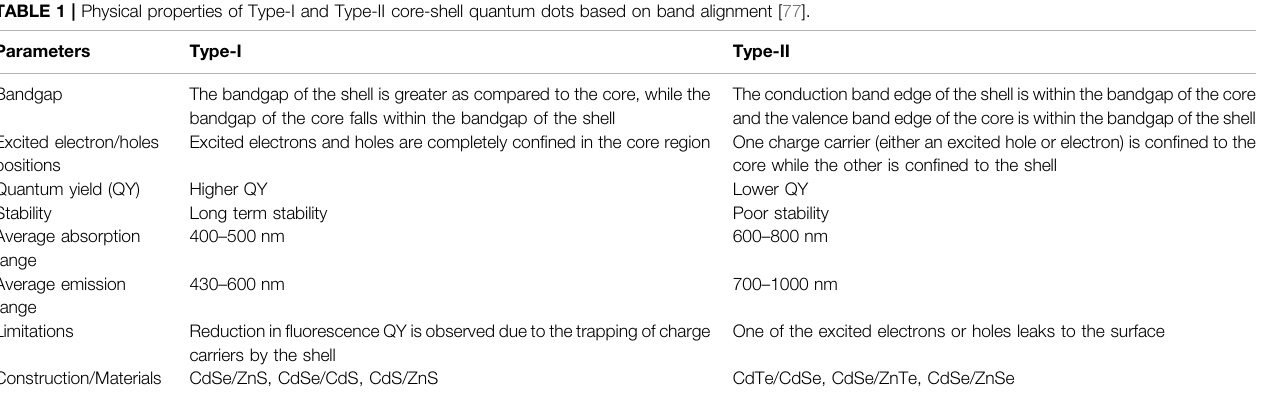
TABLE 1 | Physical properties of Type-I and Type-II core-shell quantum dots based on band alignment [77].